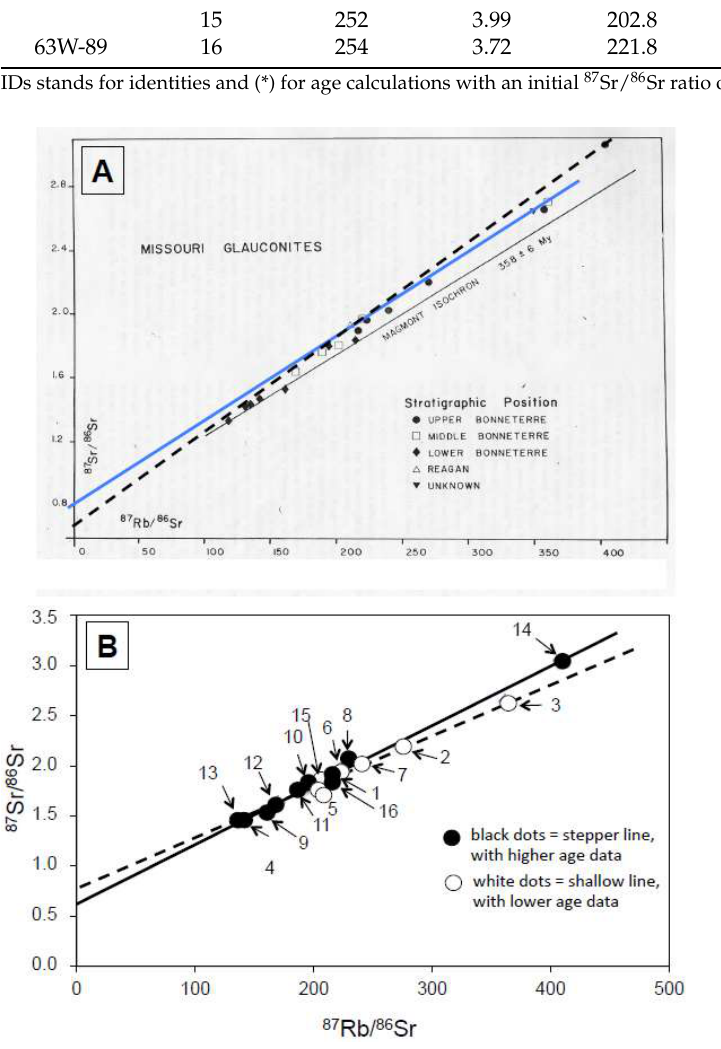
Figure 3. ( A ) A Rb-Sr display of the data from glauconite-rich pellets analyzed by Posey et al. [20] split into two lines (in black dots and full blue) of the samples studied here. The Magmont isochron published by Stein and Kish [30] is also given. ( B ) A view of the earlier Rb-Sr data from the samples studied here by K-Ar. In summary, the Rb-Sr data of Posey et al. [20] confirm a scatter at least in the Mid- dle and Upper Bonneterre sediments that was very slightly affected by a thermal increase that either accompanied or not metal-rich fluid flows at a fairly low burial depth and temperature. Obviously, this event affected accessory minerals hosted by the pellets or even favored new crystallizations of minerals enriched in Sr with an 87 Sr/ 86 Sr ratio above that of the main glauconitic minerals of the pellets. Such an occurrence may have in- creased the overall 87 Sr/ 86 Sr ratio of the heterogeneous pellets and consequently would have decreased the calculated ages. However, detritus can remain after sample purifica- tion as indicated by the XRD data and the fact that two Rb-Sr data are abnormally high in Harper’s [55] diagram. Therefore, the Rb-Sr ages of potential stratigraphic value set the references at 384 + 11 Ma (2σ) and 369 + 15 Ma, the values overlapping analytically. The high initial 87 Sr/ 86 Sr ratio of 0.710 used by Posey et al. [20] is justified due to an identified diagenetic impact that affected the host formations and, therefore, the pellets after the deposition of the host sediments, during one or even repetitive episodes at or between about 385 and 370 Ma ago.